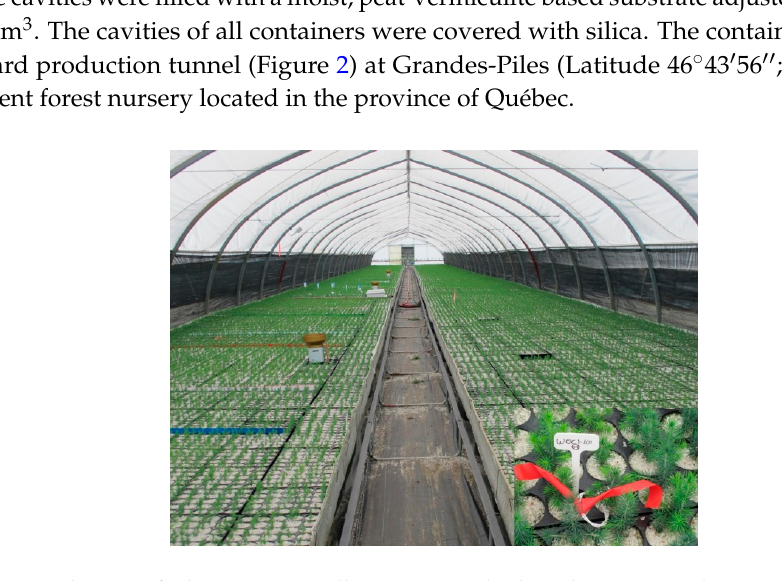
Figure 2. Production of white spruce seedlings in a standard production tunnel at Grandes-Piles forest nursery (Grandes-Piles, QC, Canada). Note in the corner at the bottom right, the insertion of a sensor into a cavity of 25–310 containers, in the presence of a white spruce seedling.